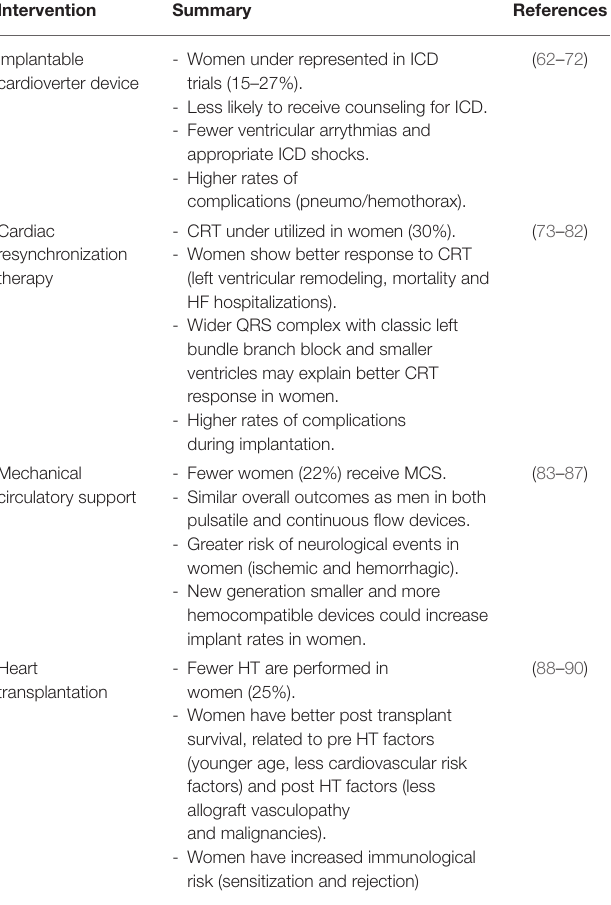
TABLE 2 | Advanced heart failure therapies in women: summary and key messages.